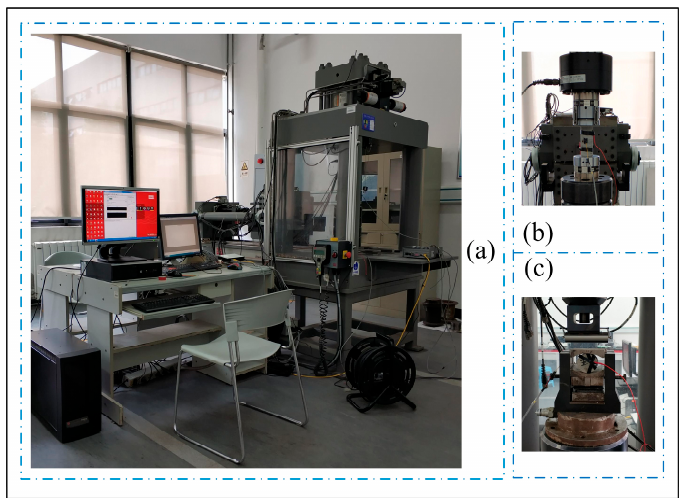
Figure 5. Quasi-static test methods: ( a ) MTS816 system; ( b ) uniaxial compression tests; ( c ) Brazilian tests. Table 1. Basic physical and mechanical properties of sandstone.